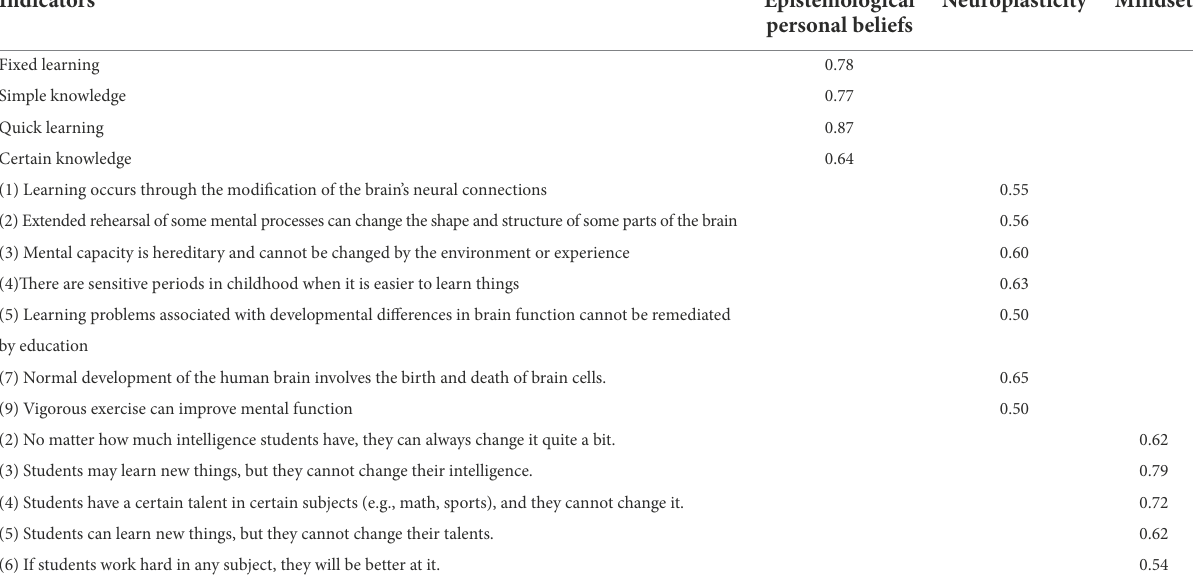
TABLE 1 Factor loading for the main variables in the study.